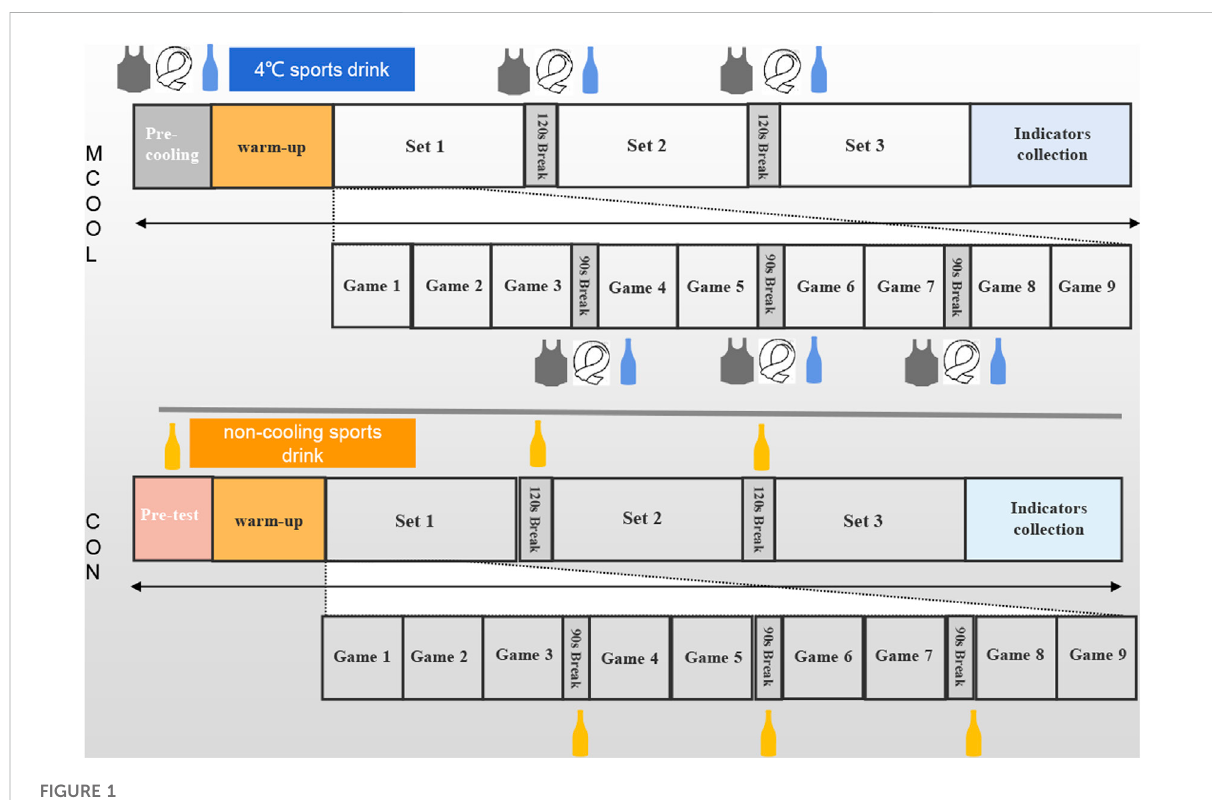
FIGURE 1 Mixed-cooling